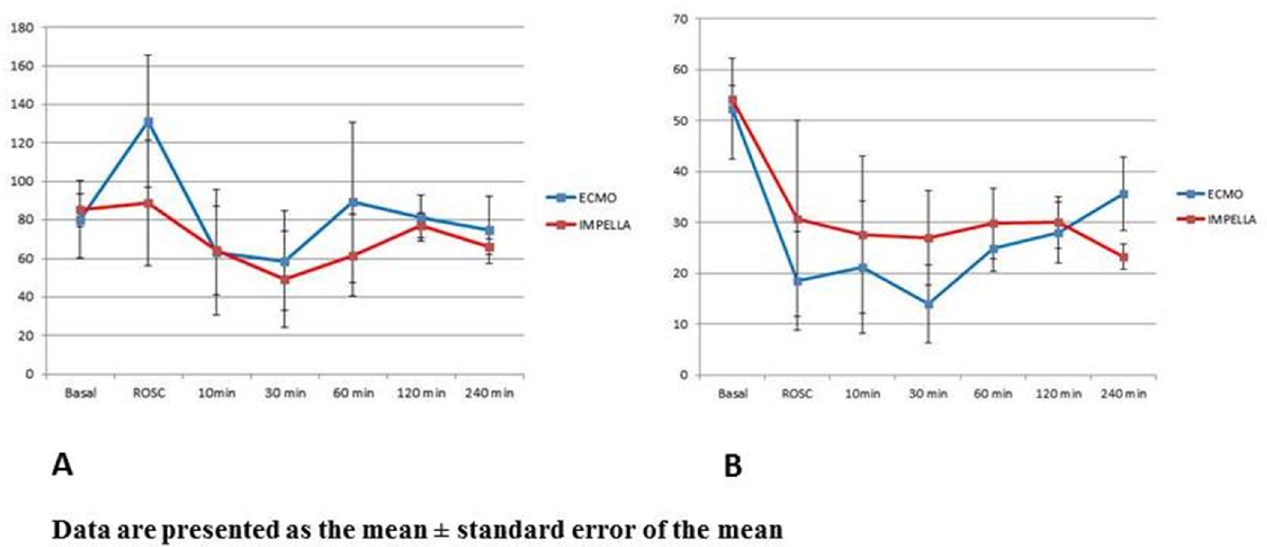
Figure 3. Mean aortic pressure ( A ) and left ventricle ejection fraction ( B ). Table 2. Myocardial function data.